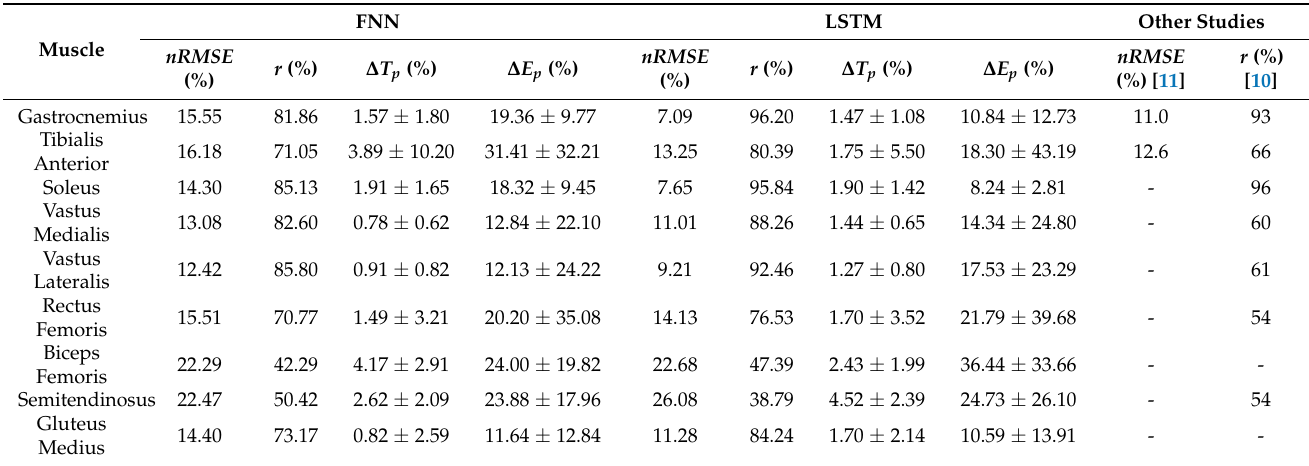
Table 3. Comparison between the actual and predicted EMG for unseen subject data and with other studies.